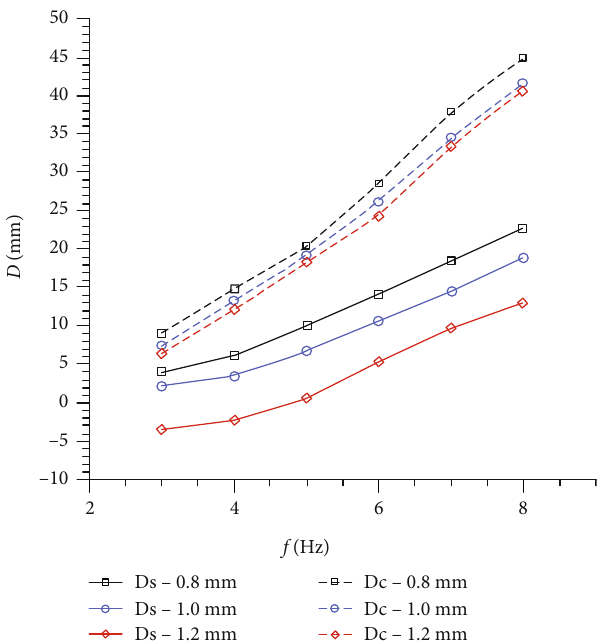
Figure 18: Relationship between sti ff ness and